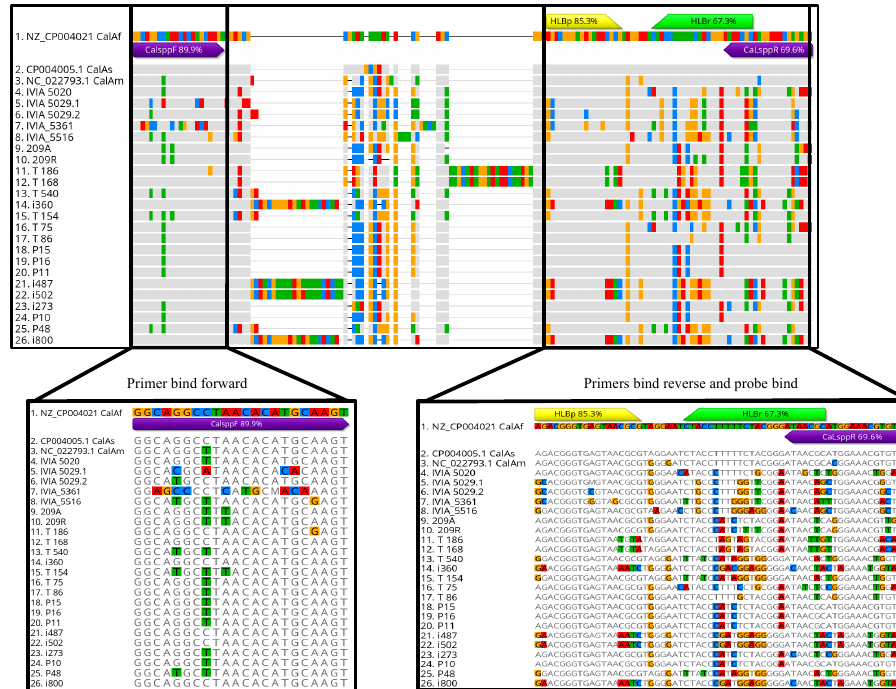
Figure 1. Partial sequence alignment obtained with the primers designed in this study and positioning of the primers described by Bertolini et al. [19] (CalsppR/CalsppF), in purple, Li et al. [21] primer (HLBr) and probe (HLBp), in green and yellow, respectively, within the sequence of ‘Candidatus Liberibacter’ spp.